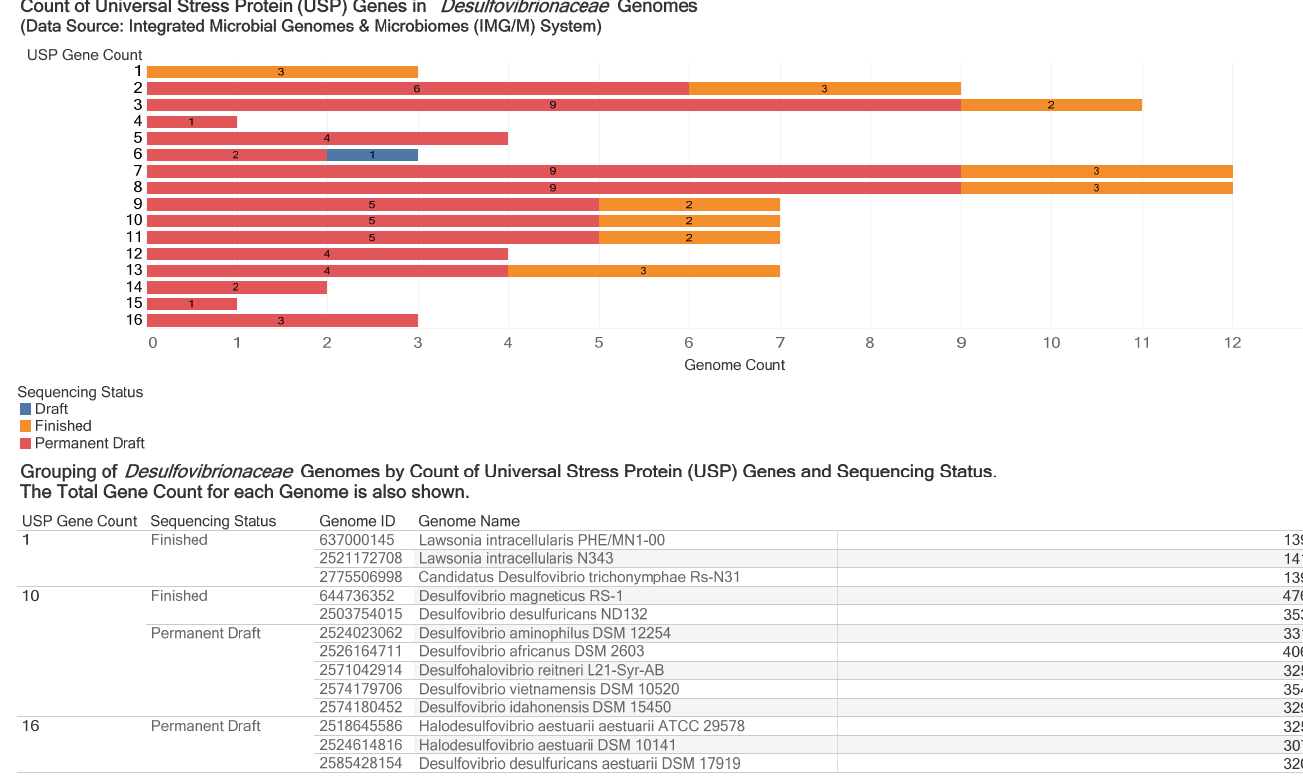
Figure 2. The count of universal stress protein (USP) genes in Desulfovibrionaceae Genomes. The bar plot shows the distribution of the gene count by genome count categorized by sequencing status (draft, finished and permanent draft) of the genome. The enclosure table shows examples of genomes with particular gene counts. We have shown genomes with 1, 10 and 16 USP gene count types and the associated total gene count. Among the genomes with USP gene count of 10 is Desulfovibrio desulfuricans ND132, a model for bacterial mercury methylation.